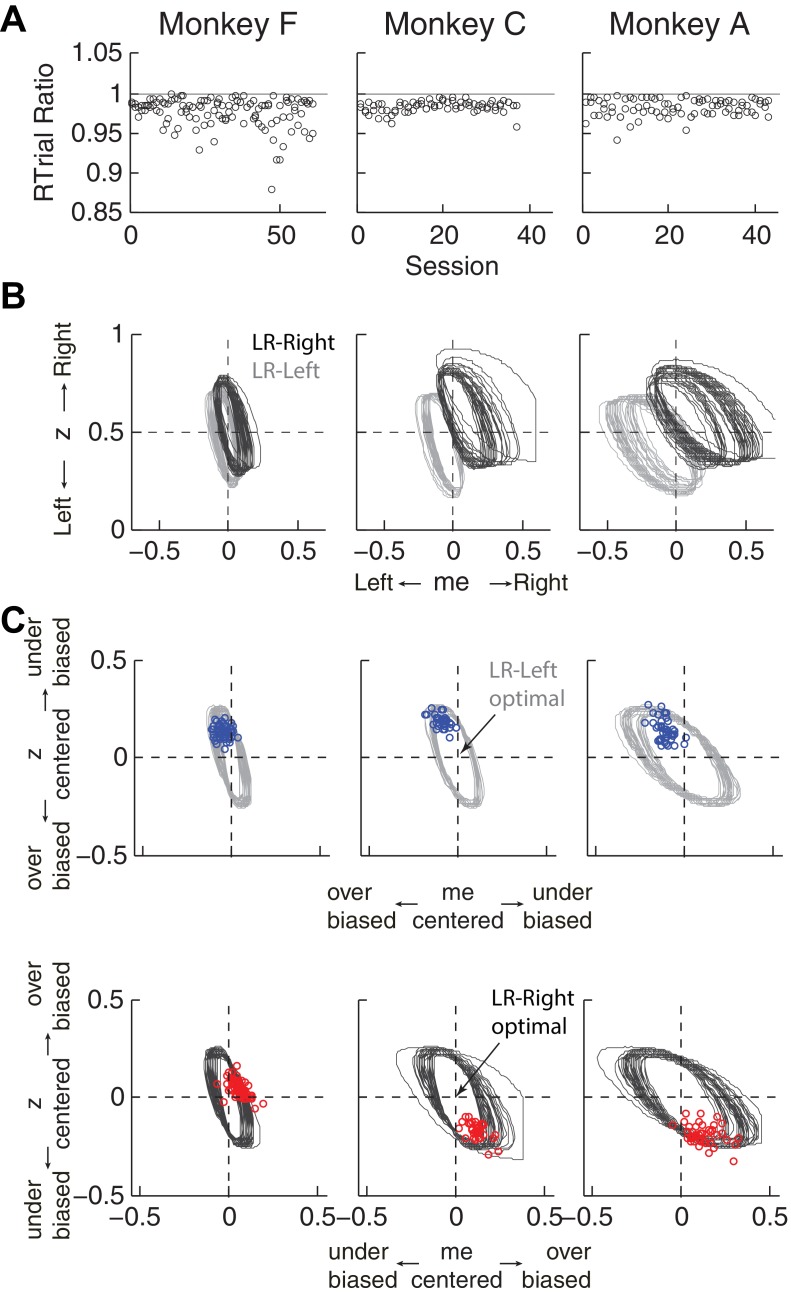
Predicted versus optimal reward per trial (RTrial).(A) Scatterplots of RTrialpredict:RTrialmax ratio as a function of session index. Each session was represented by two ratios, one for each reward context. (B) 97% RTrialmax contours for all sessions, computed using the best-fitting HDDM parameters and experienced coherences and reward ratios from each session. Light grey: LR-Left blocks; Dark grey: LR-Right blocks. (C) The monkeys’ adjustments (blue: LR-Left blocks, red: LR-Right blocks) were largely within the 97% RTrialmax contours for all sessions and tended to cluster in the me over-biased, z under-biased quadrants (except Monkey F in the LR-Right blocks). The contours and monkeys’ adjustments are centered at the optimal adjustments for each session.